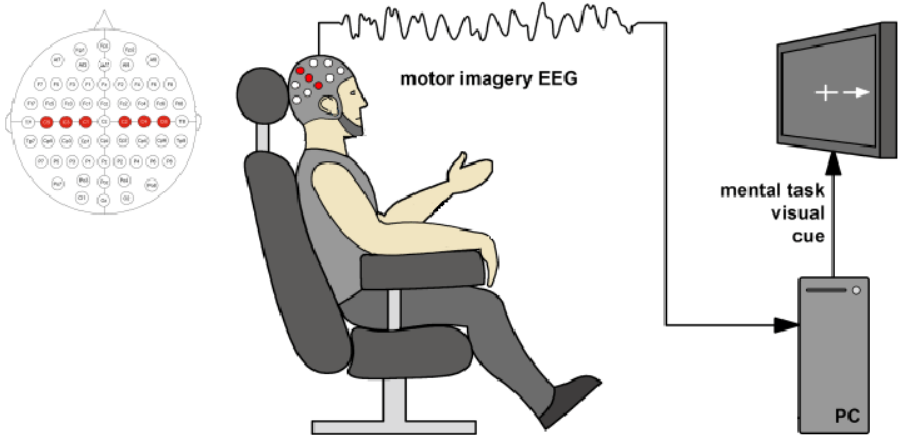
Figure 1. Experimental setup of validation methodology performed for Motor Imagery-based BCI. Source: Adapted from